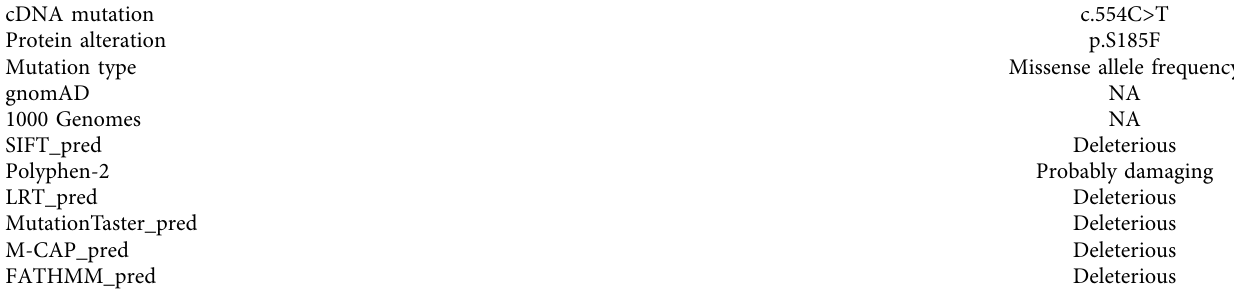
Table 2: Analysis of the MMUT mutation in the MMA patient.